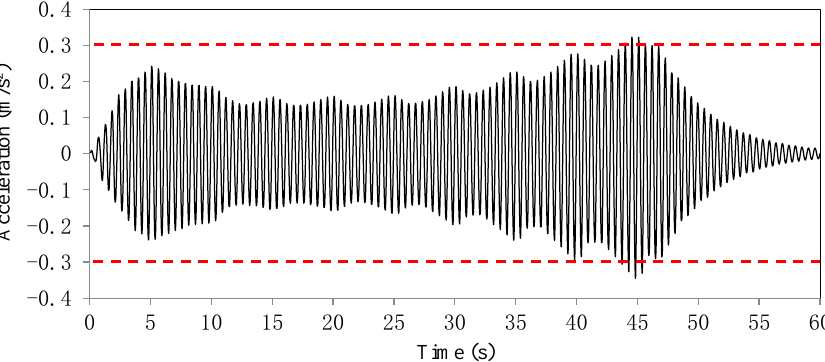
Figure 5. Plot of the time history result of the mid-span lateral acceleration of the third span of the investigated bridge (unit: m/s 2 ).